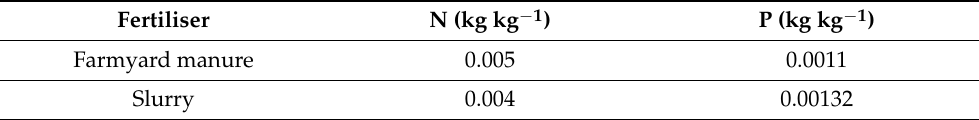
Table A4. Nitrogen (N) and phosphorus (P) content in the organic fertilisers used for the input calculations.